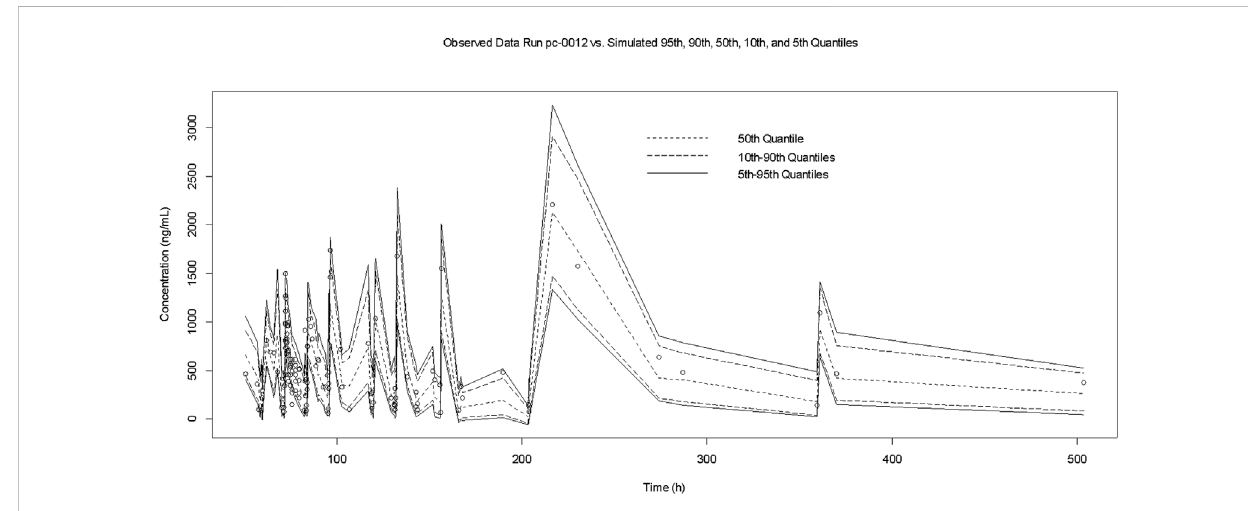
FIGURE 2 VPC graph of the fi nal popPK